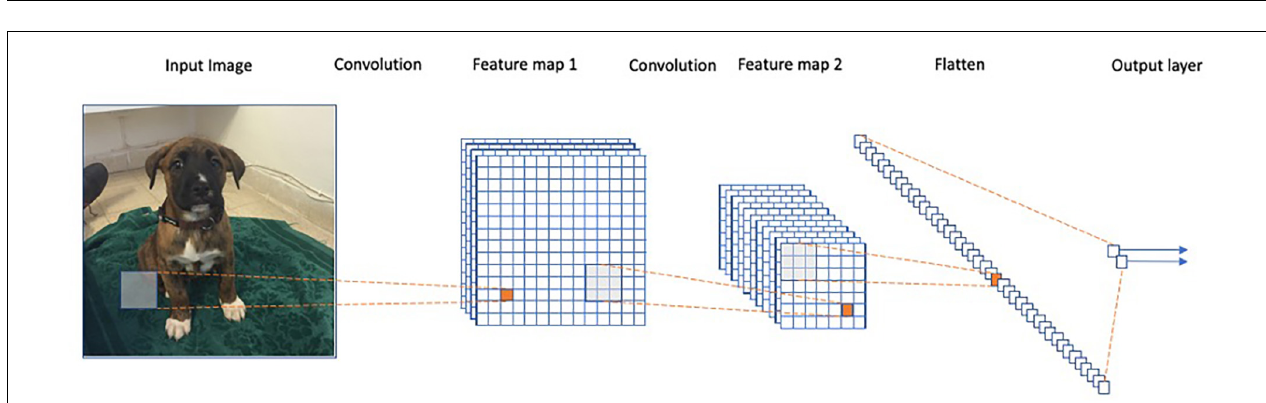
FIGURE 1 | Schematic representation of neural nets. Each circle corresponds to a neuron in a neural net. A neuron is typically a linear function of the previous layer followed by a non-linearity. Left: A neural net with a single hidden layer. Right: Deep neural net with 3 hidden layers.